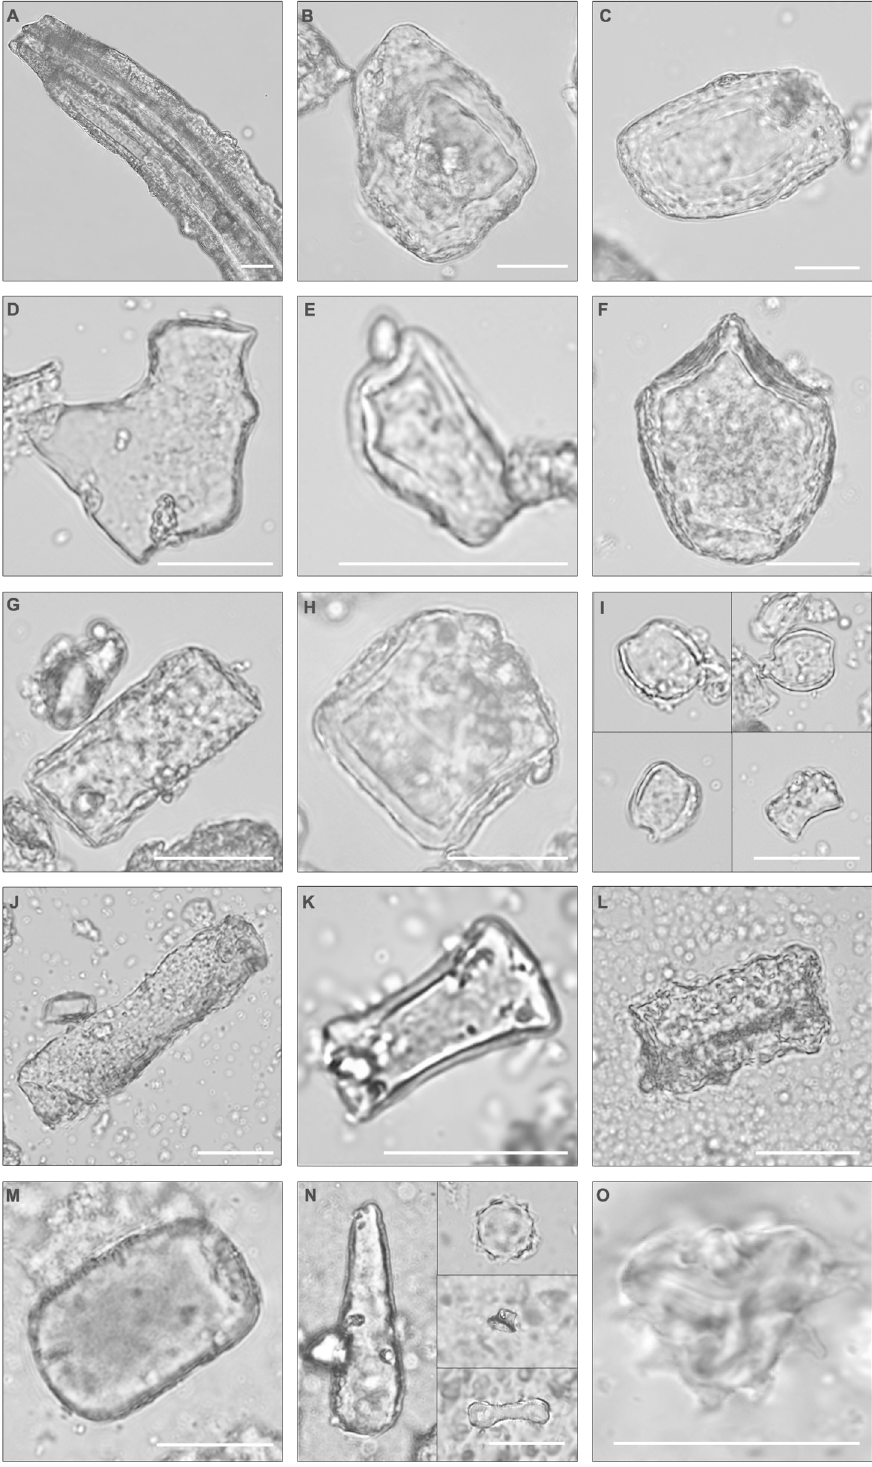
Fig. 6 Photomicrographs of selected phytoliths and pollen from Bed I. a Large tabular sulcate cf. Pteridaceae. b , c Blocky phytoliths from woody dicots. d Epidermal piece cf. Pteridaceae. e Tabular bi fi d cf. Pteridaceae (e.g. Cyrtomium ). f Bulliform, Poaceae. g Tabular. h Shield cf. Solanaceae. i Saddle, short, Chloridoideae. j Tabular scrobiculate. k Tabular strangulated cf. Salvadora . l Tabular sinuate from woody dicot. m Blocky from woody dicot. n Left. Clavate from woody dicot. Right. Upper: globular echinate, Arecaceae. Middle: Tower, Poaceae. Bottom: Bilobate, long, convex, Poaceae. o Asteraceae pollen from Upper Bed I, immediately underneath the Ng ’ eju Tuff. Pollen concentration = 2649; C3 Ret. Lamiaceae/Convolvulaceae, 101; Asteraceae, 72; Rutaceae, 2. All scale bars = 25 µ m.